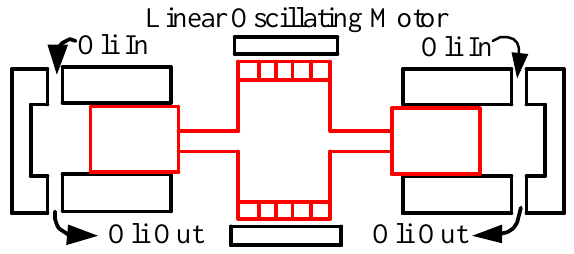
Figure 1. Diagram of linear pump.